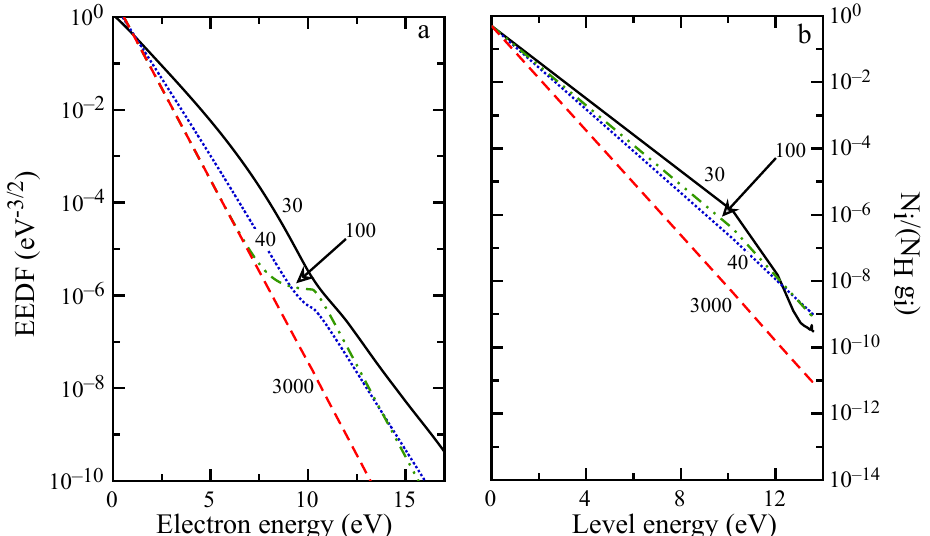
Figure 9. EEDF ( a ) and hydrogen atom internal distribution ( b ) at different positions in the recombination region for a supersonic flow at Mach 20. The curve labels represent the distances (in mm) from the shock